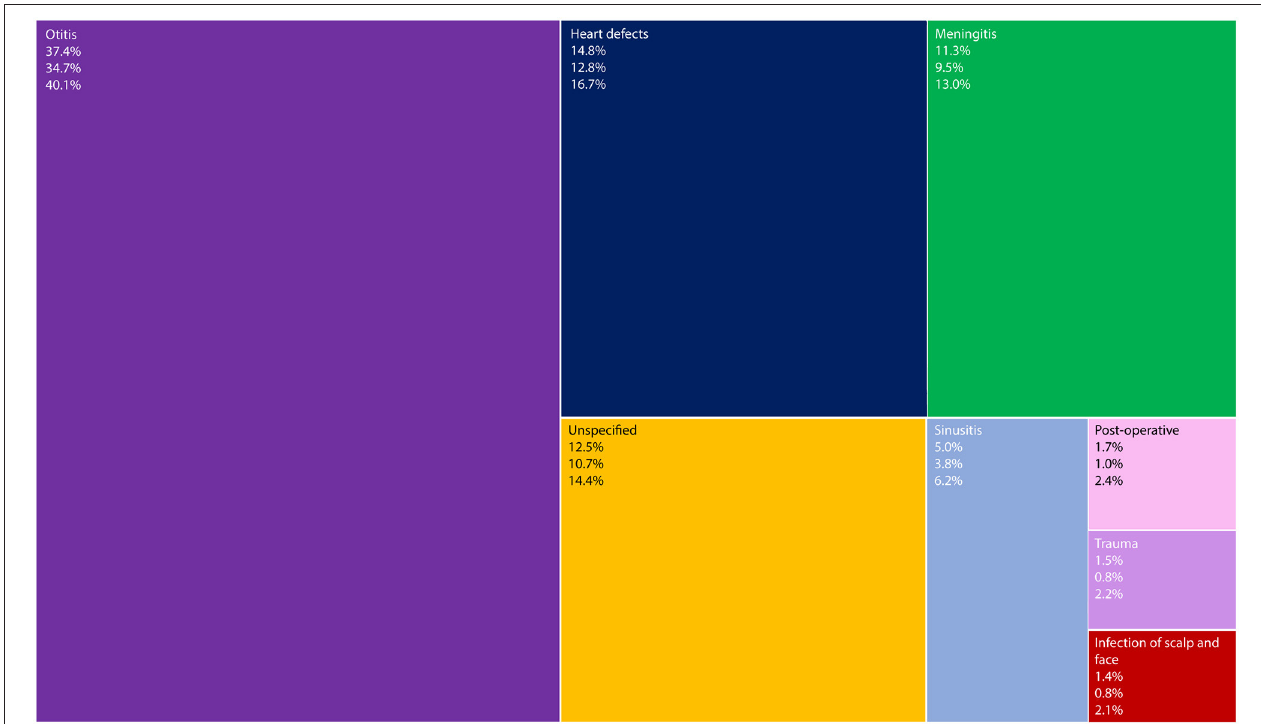
FIGURE 3 | TreeMap showing causative mechanisms of intracranial suppurations (words at the top left corner), their mean percentage (first number), lower and upper limits of the 95% confidence interval (second and third numbers, respectively).